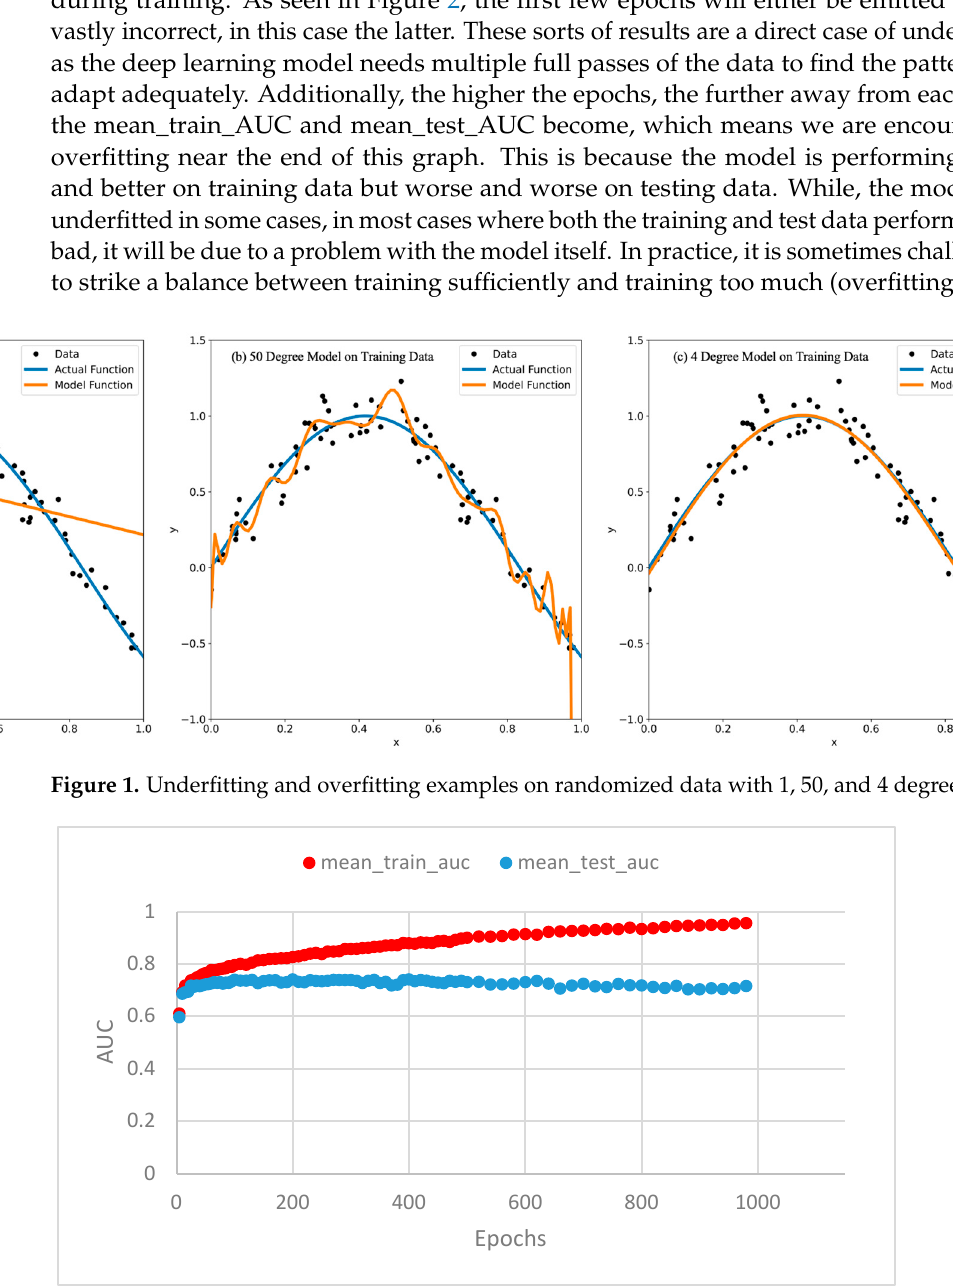
Figure 2. Training epoch with AUCs.